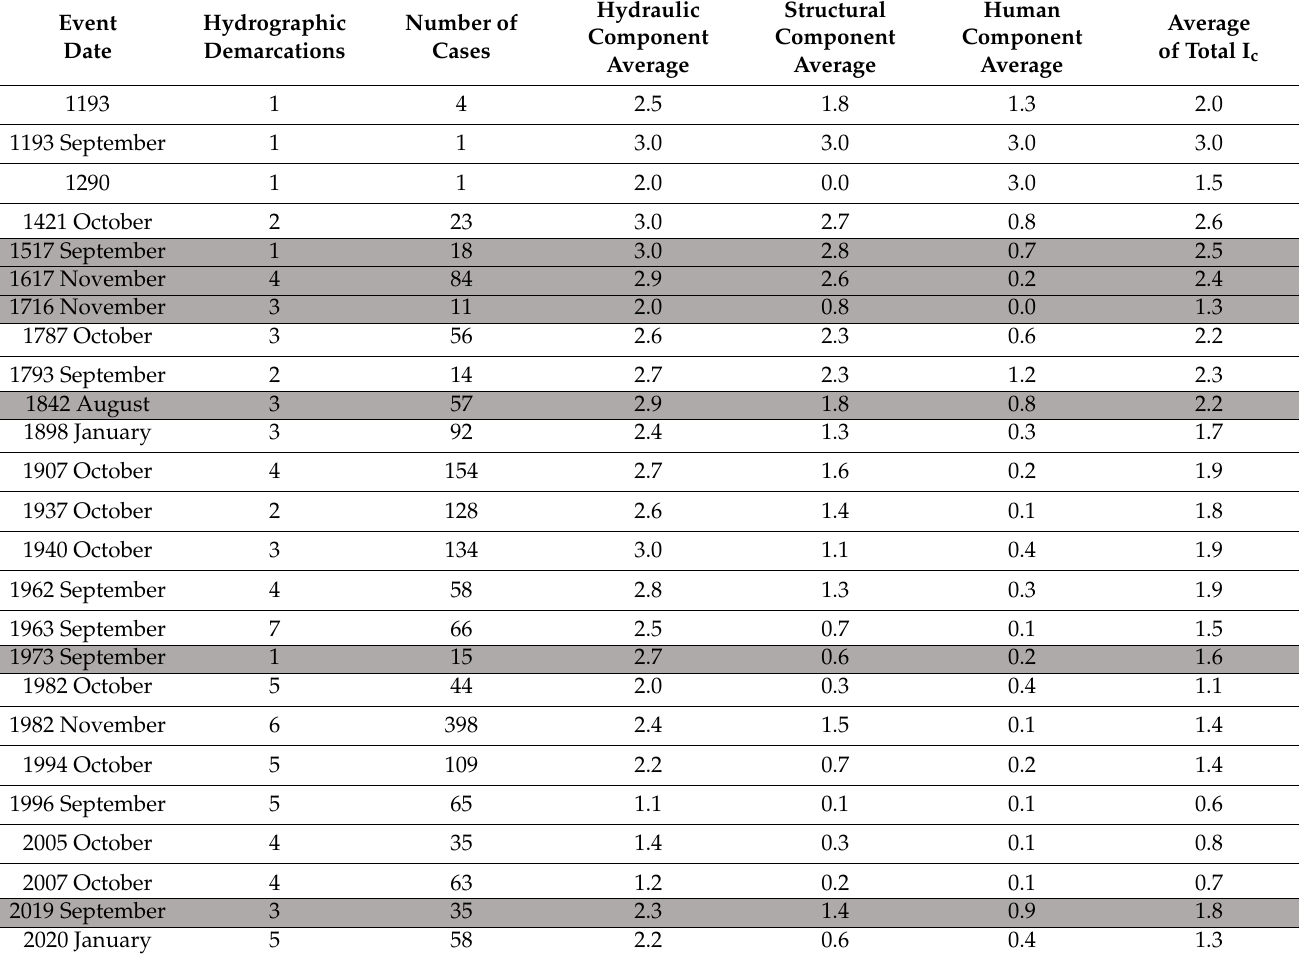
Table 3. Results obtained from the application of the index I c on different flood